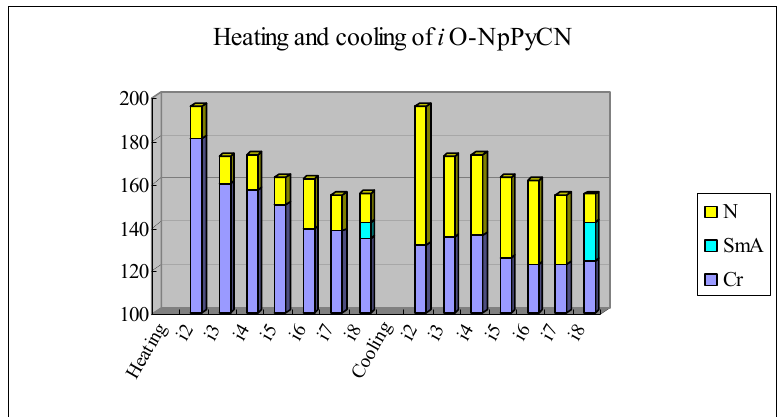
Figure 6. Plot of transition temperatures of heating and cooling cycle for